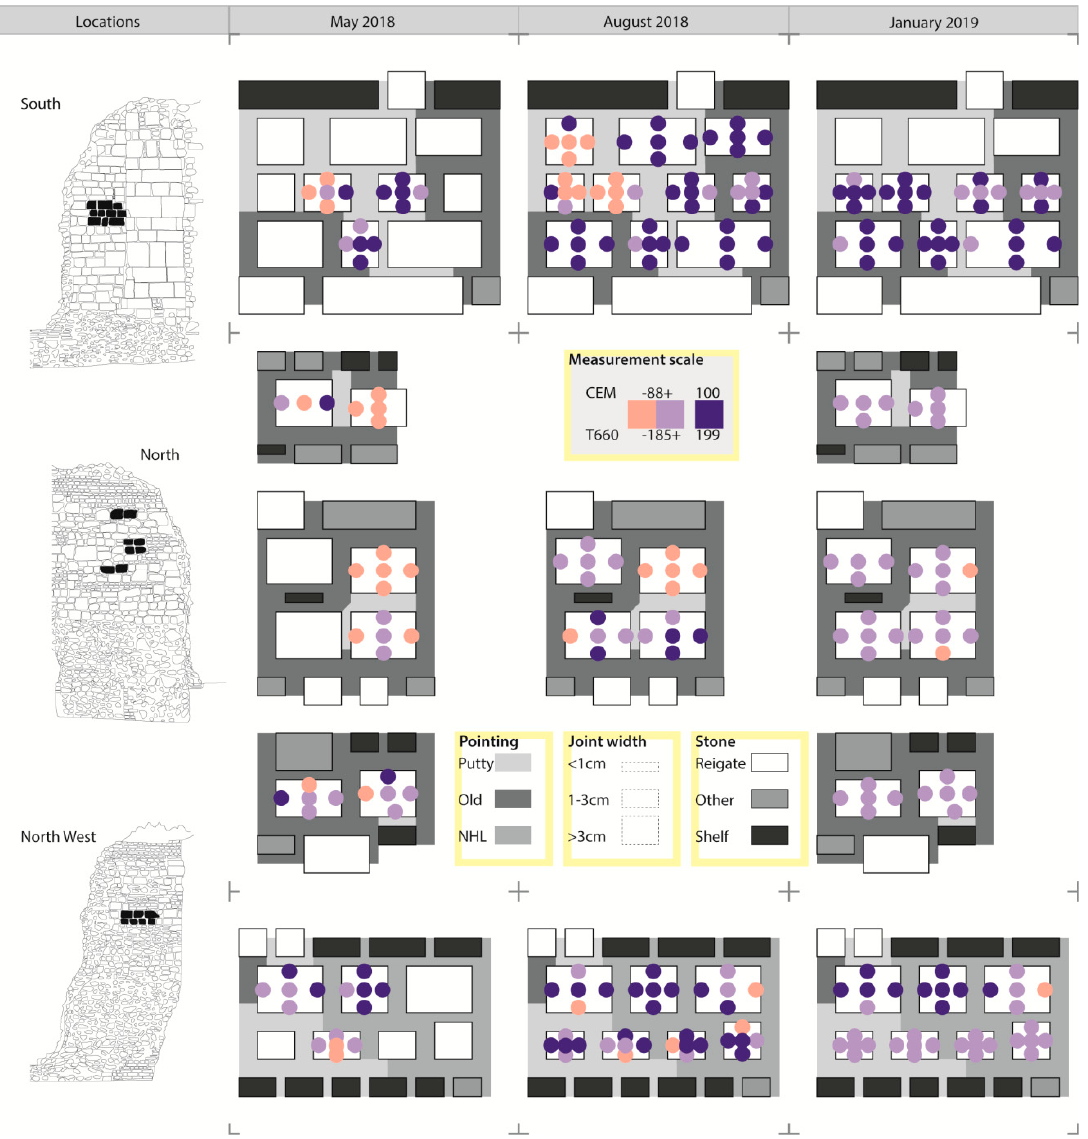
Figure 5. Distribution of CEM (displays readings at 1–100) or T660 (displays at 1–200) moisture meter readings at individual stone scale across three separate surveys, showing low, high and maximum readings for individual Reigate block edges and centres (three measurements per zone). The measurements can provide some indication of differential drying following the recent wetting of the masonry prior to each survey. There is some indication that block edges adjacent to putty mortar are drying more rapidly, but no clear pattern according to mortar type or mortar width. Ambient climate and exposure (both aspect and micro-contextual shelter) provide better indicators.